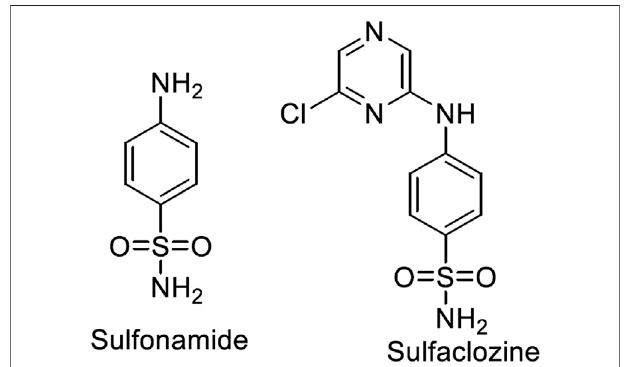
FIGURE 1 | Structures of sulfonamide and